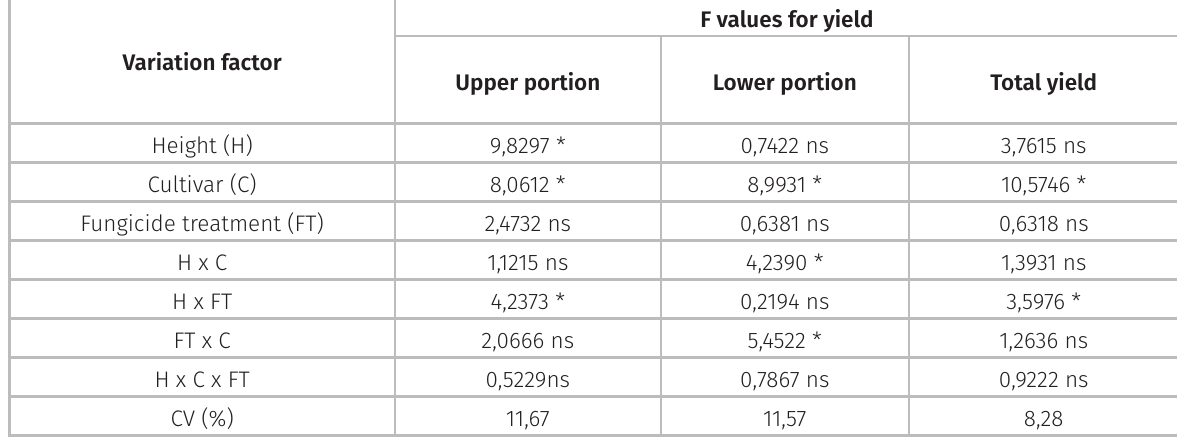
Table IV. Analysis of variance of cotton yield in the upper, lower portions and whole plant (total yield). Chapadão do Sul, MS. Crop season: